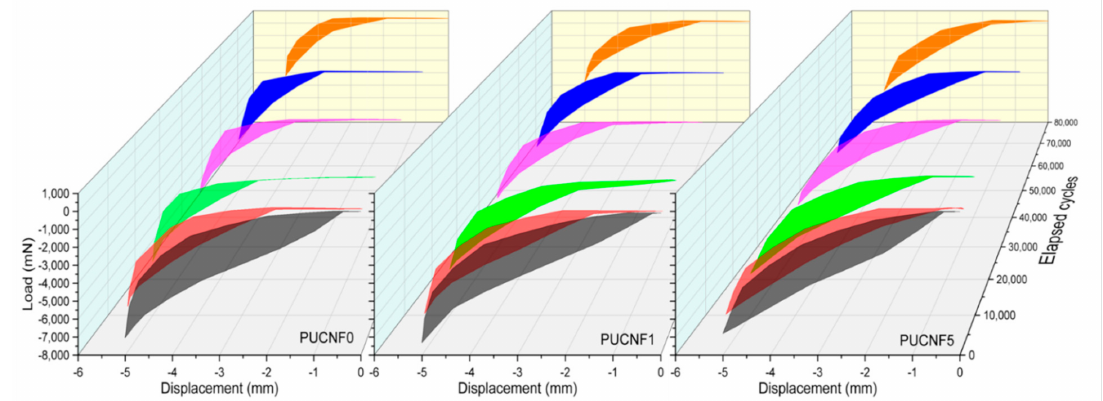
Figure 6. Development of the hysteresis behavior of the PUCNF0, PUCNF1, and